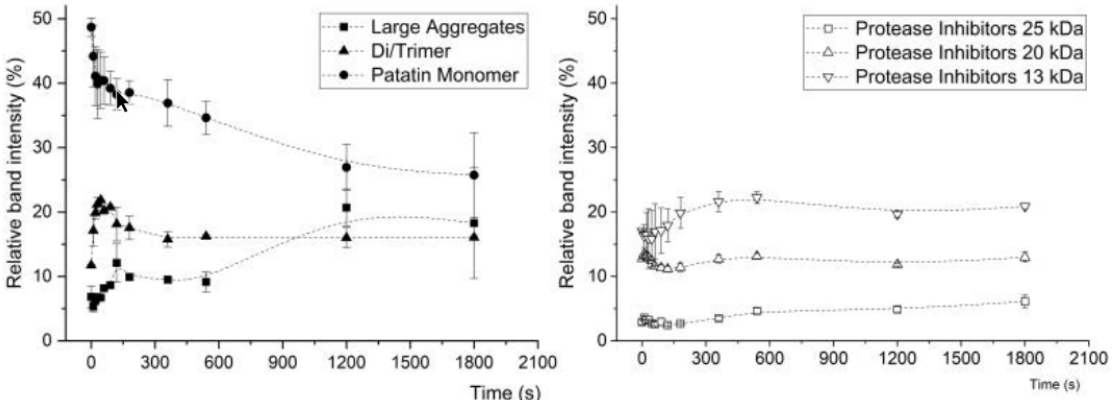
Figure 4. Change in protein amount of the patatin and aggregate fractions of a 1% PPI solution at pH 7 in dependence of the time heated at 70 ◦ C. The band intensity was averaged from two SDS-PAGE gels under non-reducing conditions, and the range is indicated by the error bars.